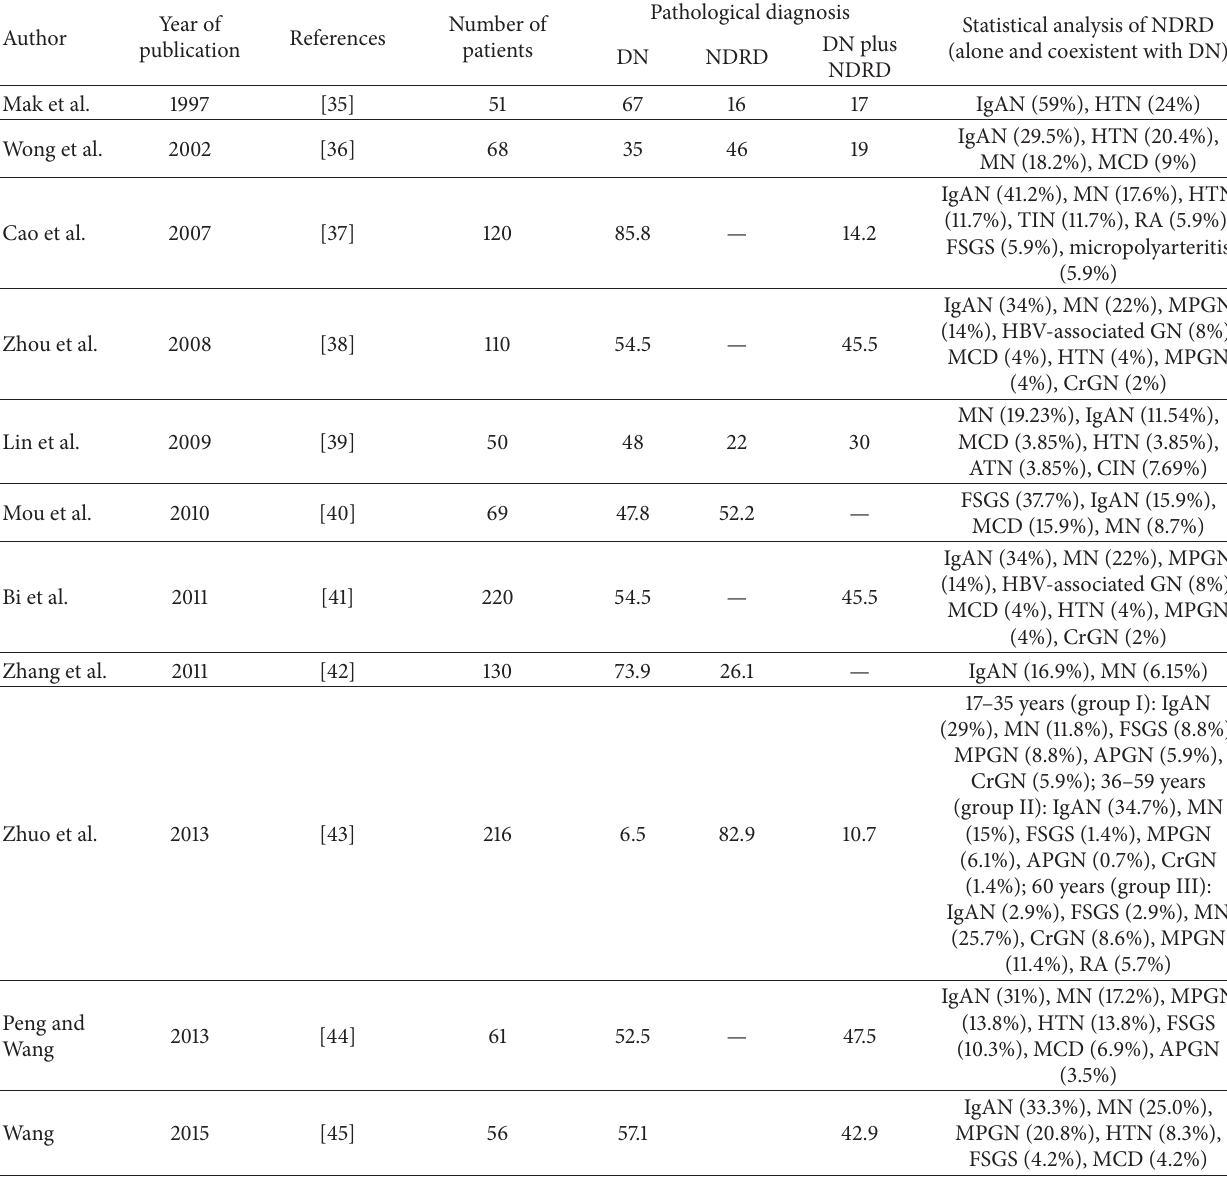
Table 4: Literature review of NDRD in